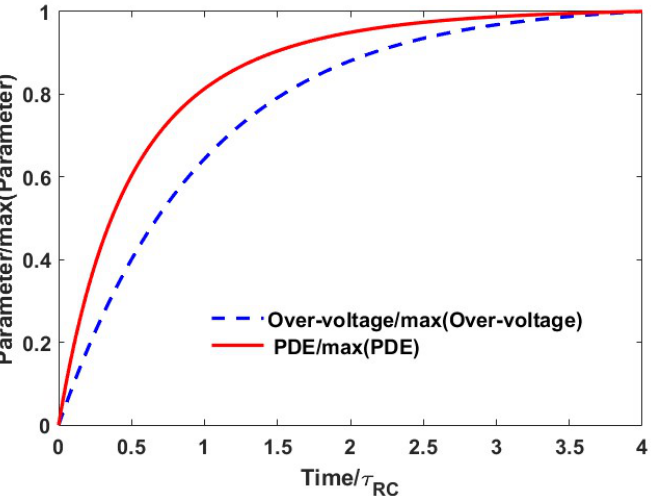
Figure 1. The recovery of the over-voltage and the photon detection efficiency determined using Equations (1) and (2).